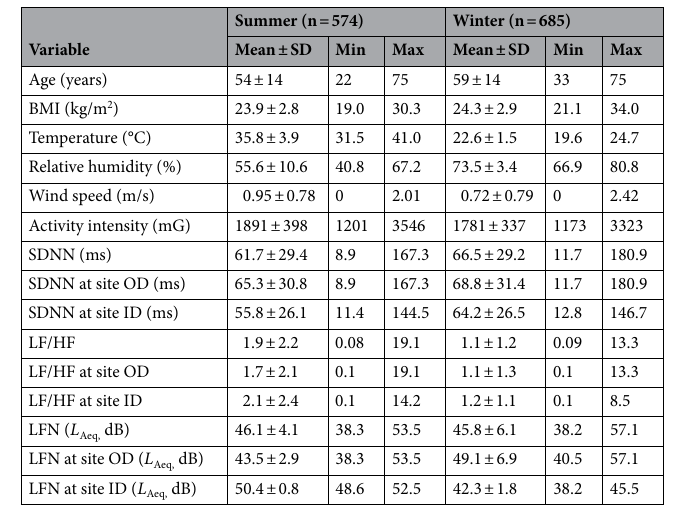
Table 1. Demographic characteristics of study subjects and environmental and LFN measurements with a 5 min resolution (n = 1259). Site OD: 20 m from wind turbines; Site ID: 500 m from wind turbines. BMI